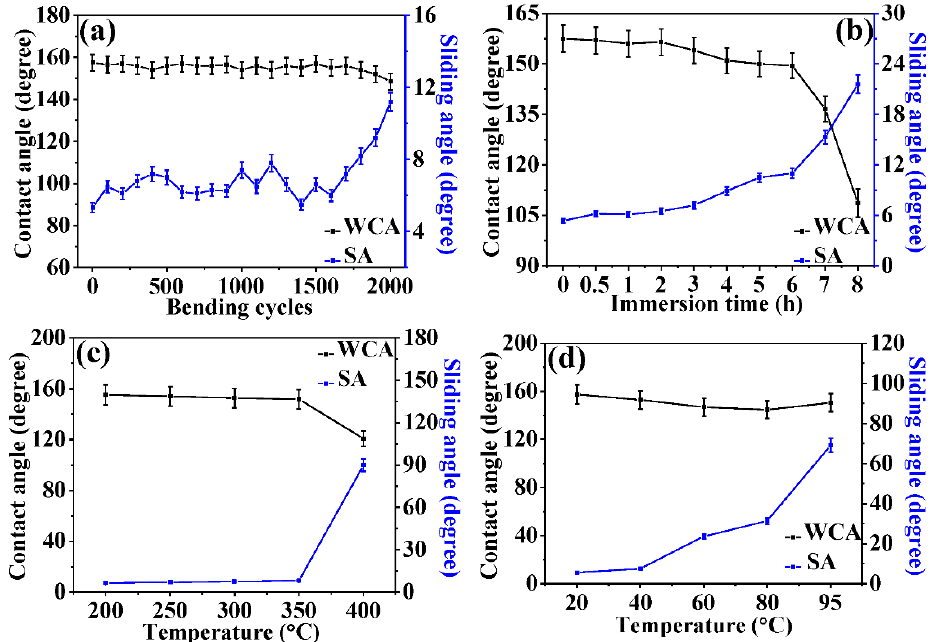
Figure 8. Change in the wettability of the FCS surface with different numbers of ( a ) bending cycles and ( b ) immersion time; ( c ) WCAs and SAs at different heating temperatures; ( d ) WCAs and SAs of water droplets (5 µL) at different temperatures.